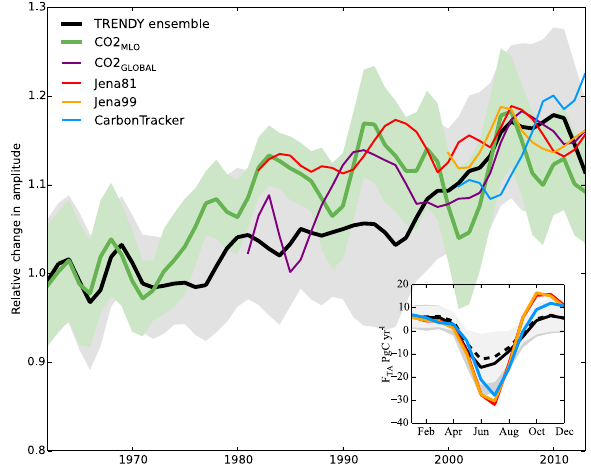
Figure 4. Trends for seasonal amplitude of TRENDY simulated multimodel ensemble mean land–atmosphere carbon flux F TA (black), of the Mauna Loa Observatory (MLO) CO 2 mixing ra- tio (CO2 MLO , green) and global CO 2 mixing ratio (CO2 GLOBAL , purple), and of F TA from atmospheric inversions of Jena81 (red), Jena99 (orange) and CarbonTracker (blue). The trends are relative to the 1961–1970 mean for the TRENDY ensemble and Mauna Loa CO 2 , and the other time series are offset to have the same mean as the TRENDY ensemble for the last 10 years (2003–2012). A 9- year Gaussian smoothing (Harris, 1978) removes interannual vari- ability for all time series, and its 1 σ standard deviation is shown for CO2 MLO (green shading). Note that the gray shading here in- stead indicates 1 σ models’ spread, which is generally larger than the standard deviation of the TRENDY ensemble’s decadal variabil- ity. Inset: average seasonal cycles of models’ ensemble mean F TA (PgCyr − 1 ) for the two periods: 1961–1970 (dashed line; lighter gray shading indicates 1 σ model spread) and 2001–2010 (solid; darker gray shading indicates 1 σ model spread), revealing enhanced CO 2 uptake during spring/summer growing season. Mean seasonal cycles global F TA from the atmospheric inversions for 2001–2010 are also shown (same color as the main figure) for comparison.